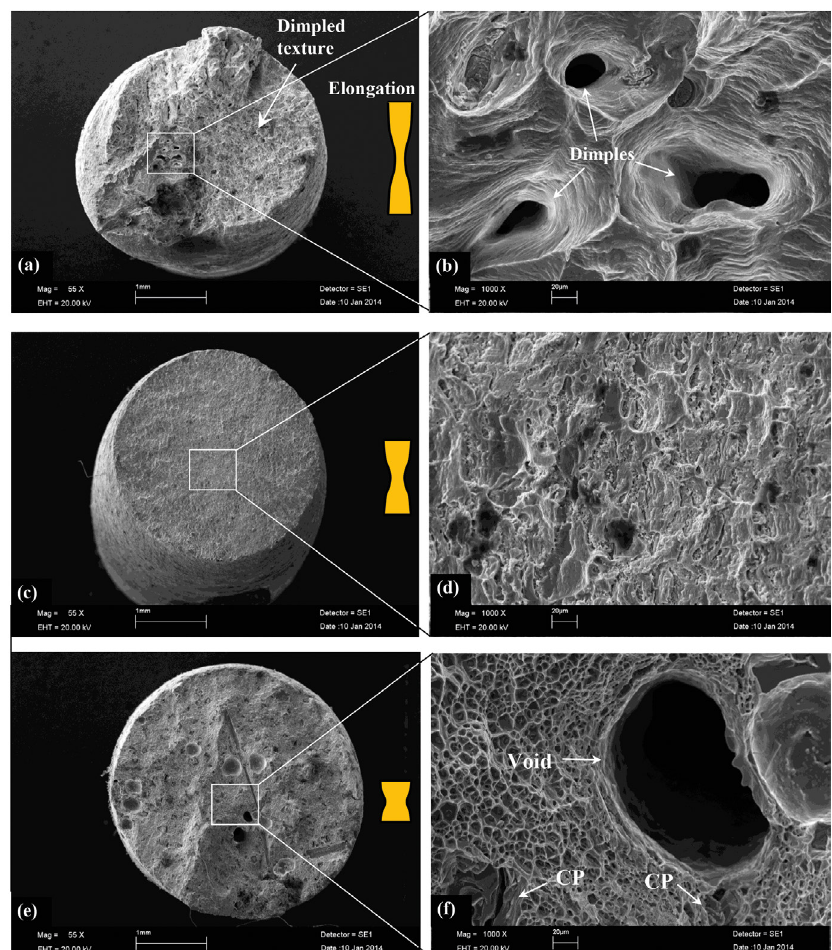
Fig. 11 SEM fractographs showing tensile fracture surface of Al–1.9Mn–xFe alloys for lowest growth velocity ( V =8.3 μm/s) (a, b) Al–1.9Mn–0.5Fe (c, d) Al–1.9Mn–1.5Fe (e, f) Al–1.9Mn–5Fe (CP: cleavage